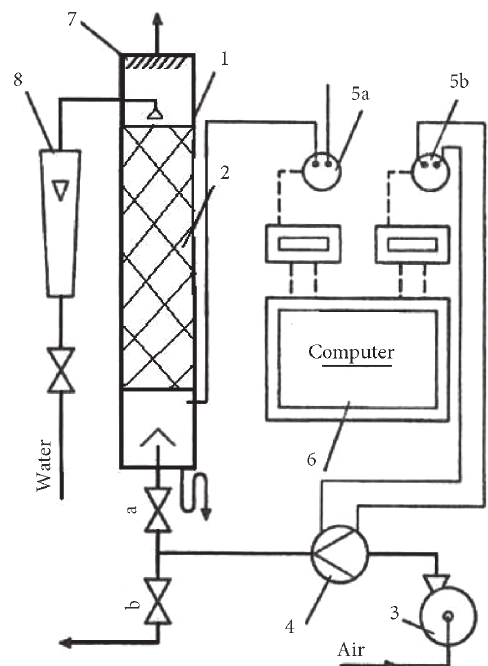
Fig. 1. The circuit of the experimental device: 1 – column; 2 – pine cones; 3 – ventilator; 4 – rate-of-flow meter; 5 – differential pressure gage; 6 – computer; 7 – mist eliminator; 8 –